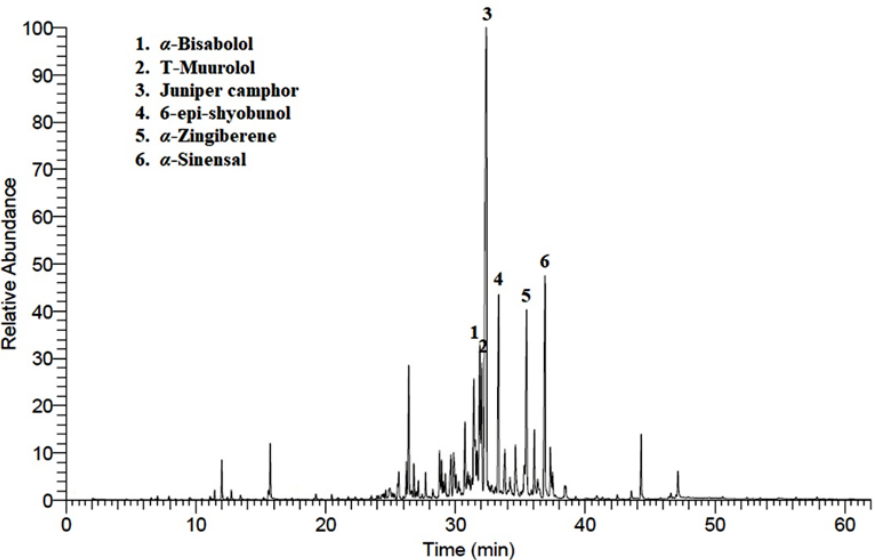
Figure 1. GC-MS chromatogram of the essential oil from the above-ground parts of Pulicaria somalensis (Shie). Peaks of the major compounds are numbered 1–6.